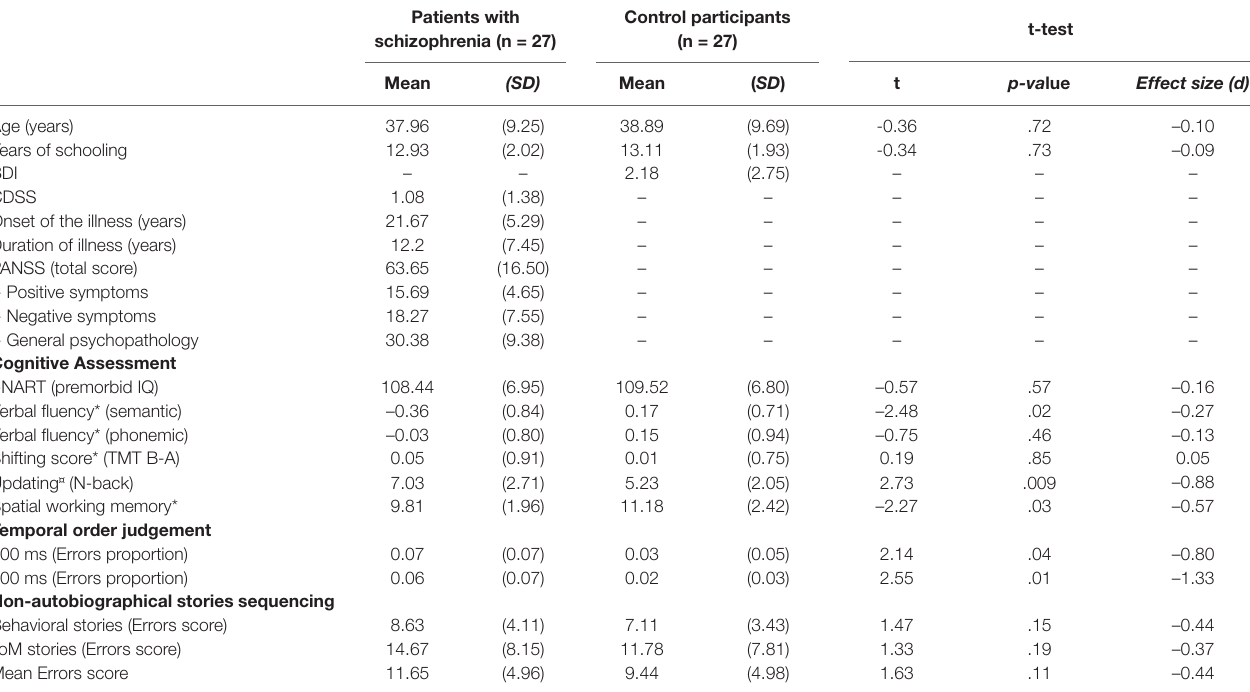
TABLE 1 | Demographic, clinical, and initial assessment measures of patients with schizophrenia and